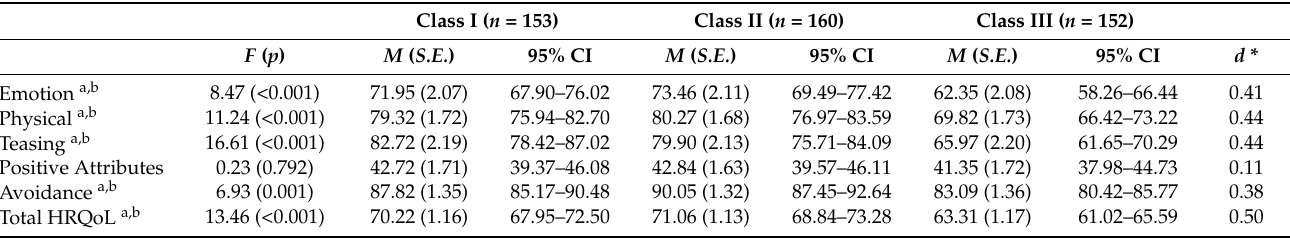
Table 3. HRQoL Differences across Obesity